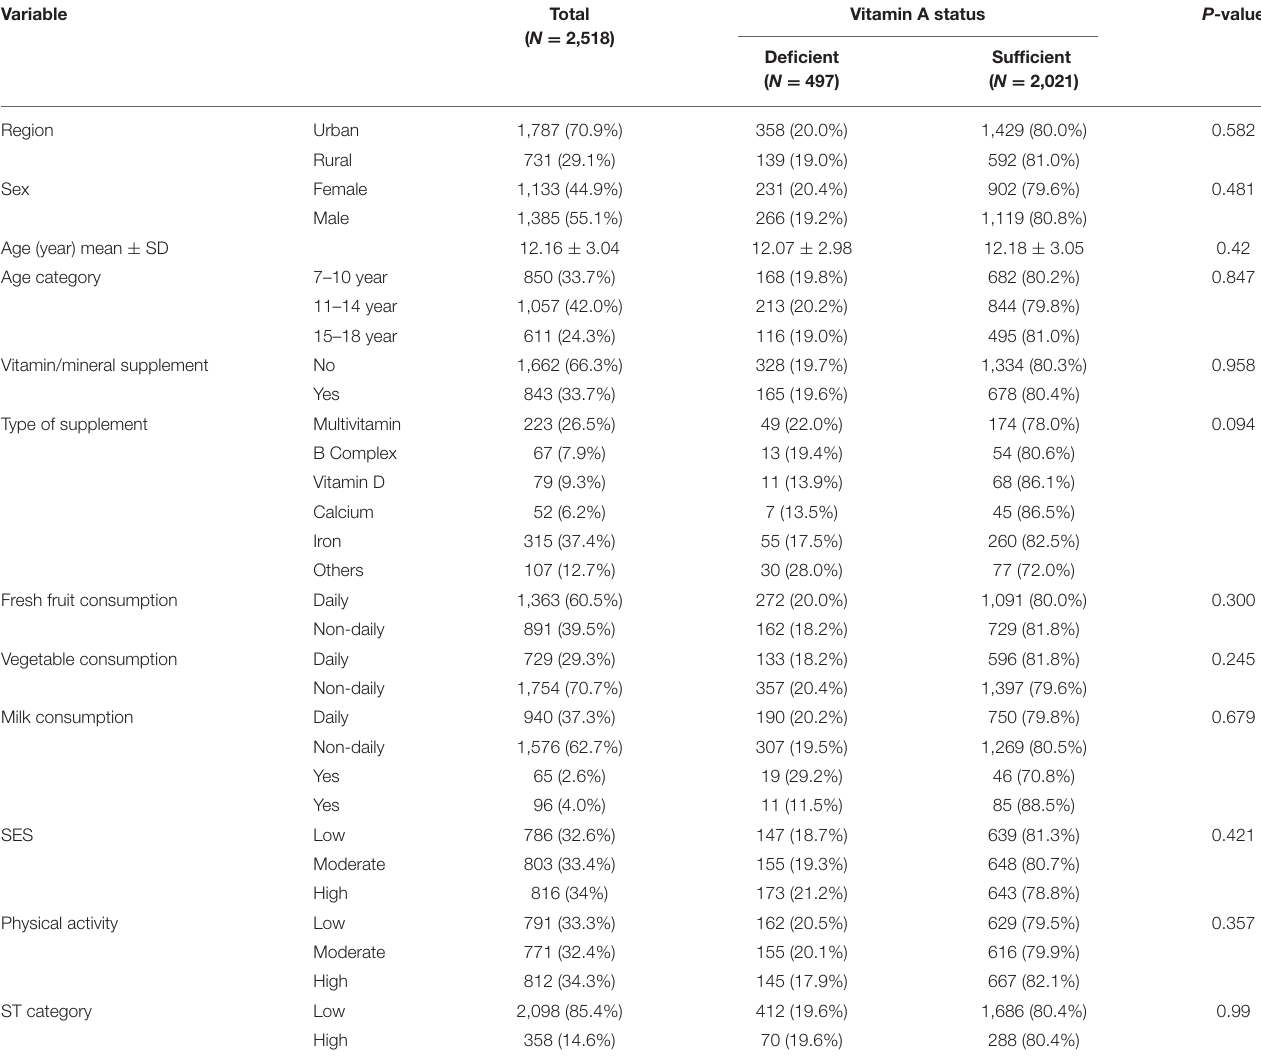
TABLE 1 | Socio-demographic, socioeconomic and life style according to vitamin A status in Iranian children and adolescents.